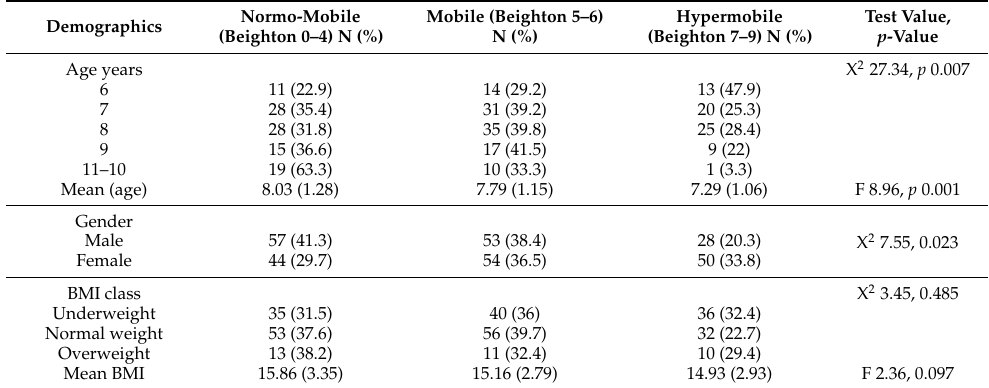
Table 2. Demographic distribution of the joint mobility groups (Beighton score range).